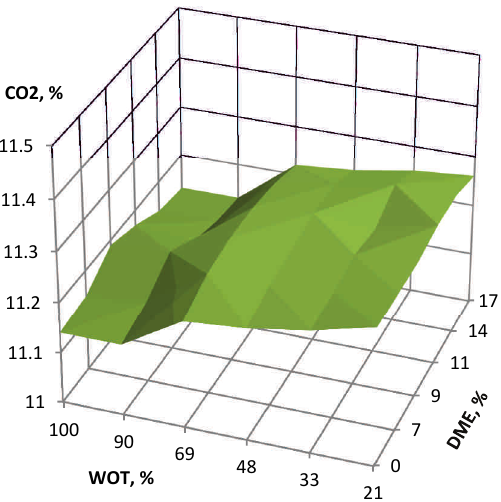
Fig. 15. Maximum in-cylinder temperature in depend of DME share & engine load, n = 2500 rpm